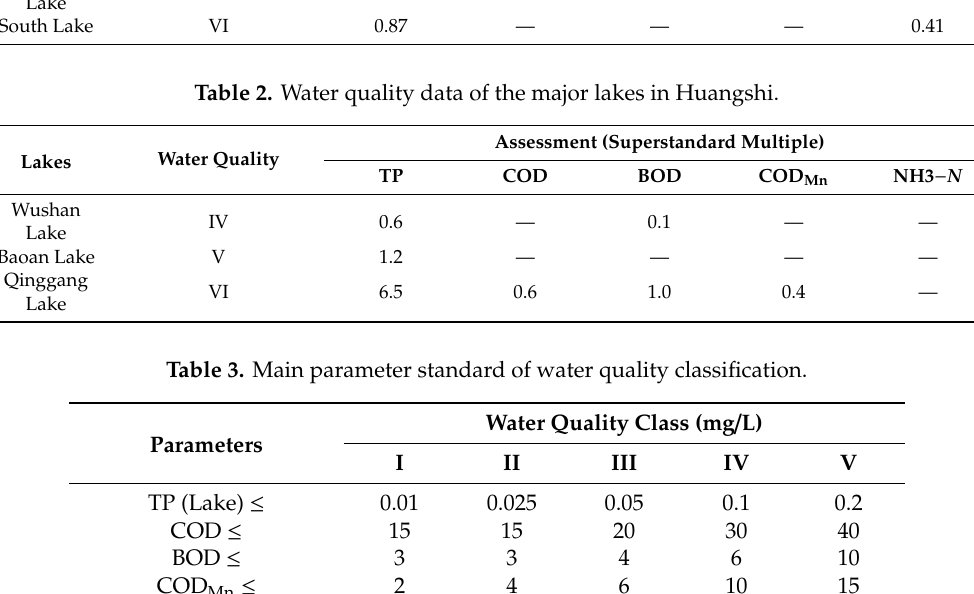
Table 2. Water quality data of the major lakes in Huangshi.